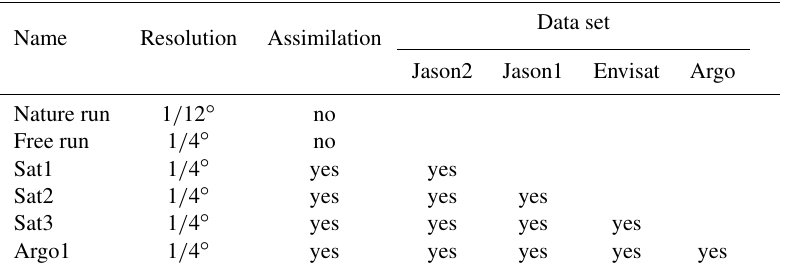
Figure 1. (a) Satellites tracks over 35 days in the North Atlantic. Blue: Jason 2; black: Envisat; red: Jason 1. (b) Argo profiles over the year 2009. Table 1. Computed simulations and assimilated data